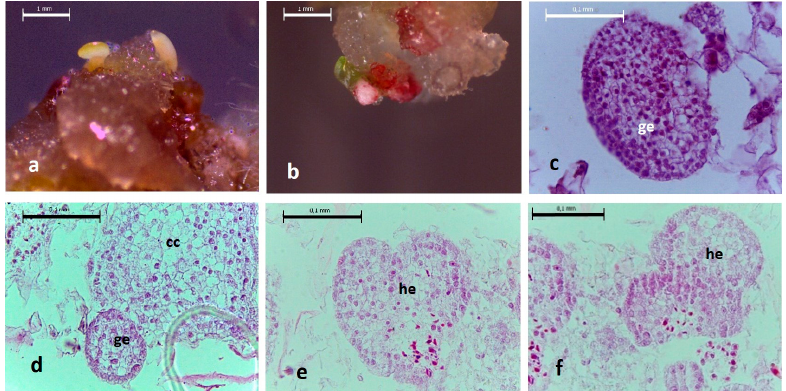
Figure 1. Histological images of embryogenic callus derived from L. racemosa hairy roots of the line LRT 2.3. ( a ) embryogenic callus at 10 dpp on MS/B5 medium supplemented with 2.0% sucrose; ( b ) embryogenic callus at 15 dpp on MS/B5 medium supplemented with 3.0% sucrose; ( c ) somatic embryo at globular stage (ge) 10 dpp; ( d ) Compact callus (cc) and somatic embryo at globular stage (ge) 10 dpp; ( e , f ) somatic embryos at heart step (he) 15 dpp. ( a , b ) (20×) scale bar 1.0 mm, ( c – f ) (40×) scale bar 0.1 mm.